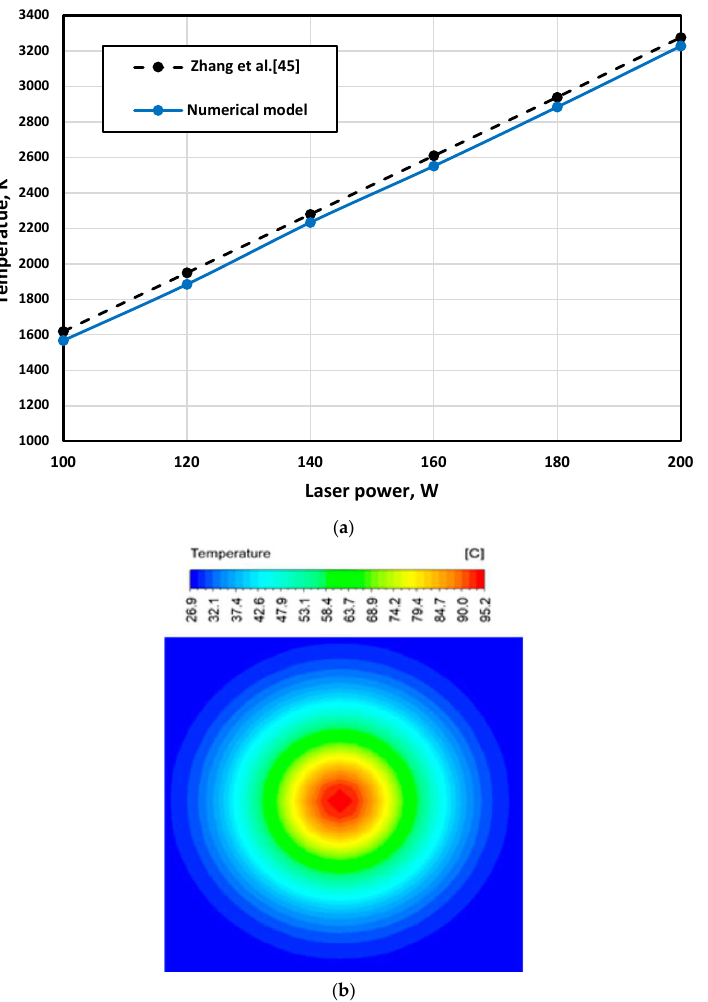
Figure 9. Validation results of the developed model: ( a ) comparison of the maximum temperature obtained from the numerical model by Zhang et al. [45] and mesh density analysis, ( b ) comparison of the temperature contour obtained from the numerical model with the reported contour by Moser et al. and Edith Wiri et al. [38,46].